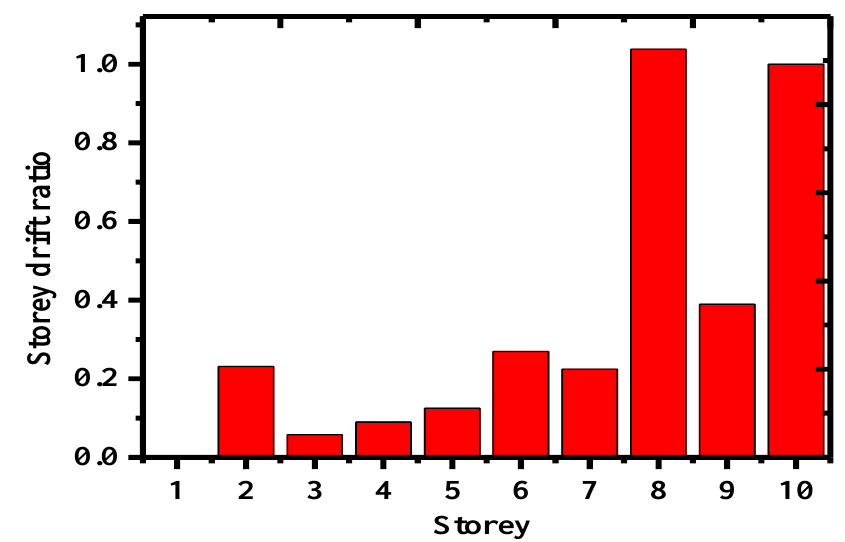
Fig. 5. Storey drift ratio of 10 storey structure. Table 4 Percentage of reduction of displacement of 10 storey structure by using cladding material.